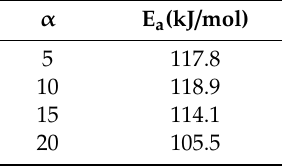
Table 3. Degradation energies at di ff erent conversions for chitin obtained from Vespa velutina .